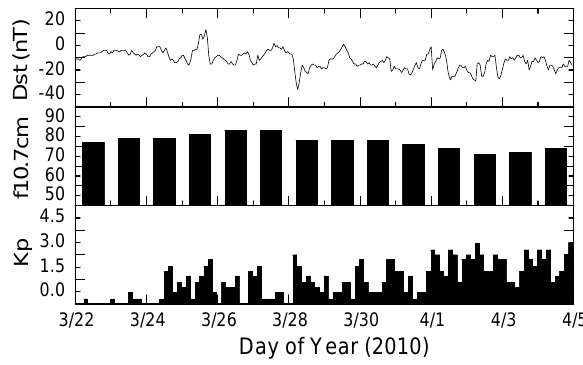
Fig. 5. Dst, F 10.7 , and K p indices during 14–27 February 2010.